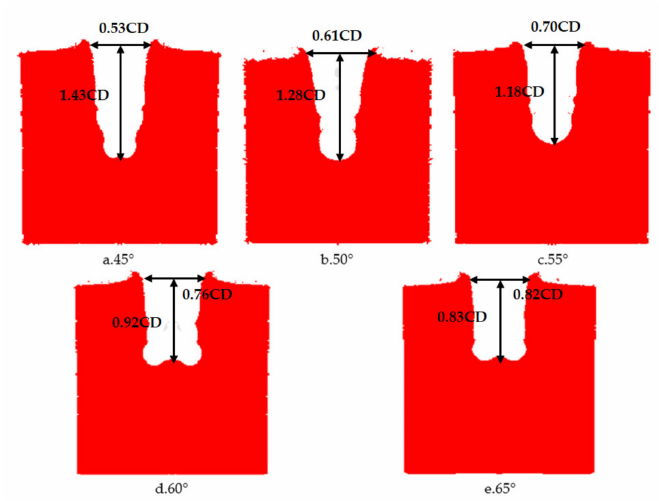
Figure 10. The damage effect of reactive charges wigth different cone angles on a steel target.